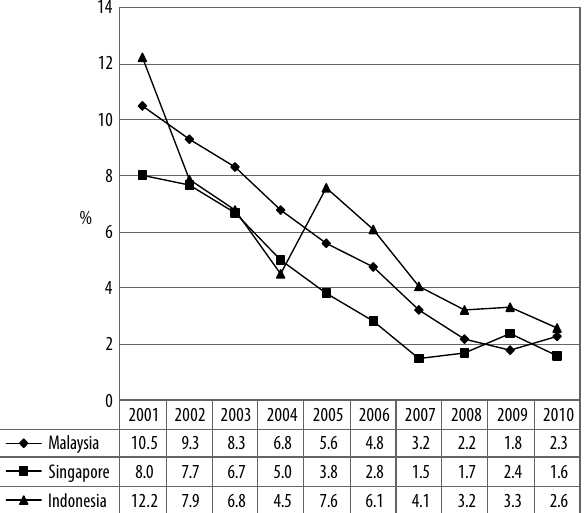
Fig. 1. Non performing loans at selected South East Asian countries (% of commercial bank loans) Source : Asian Development Bank